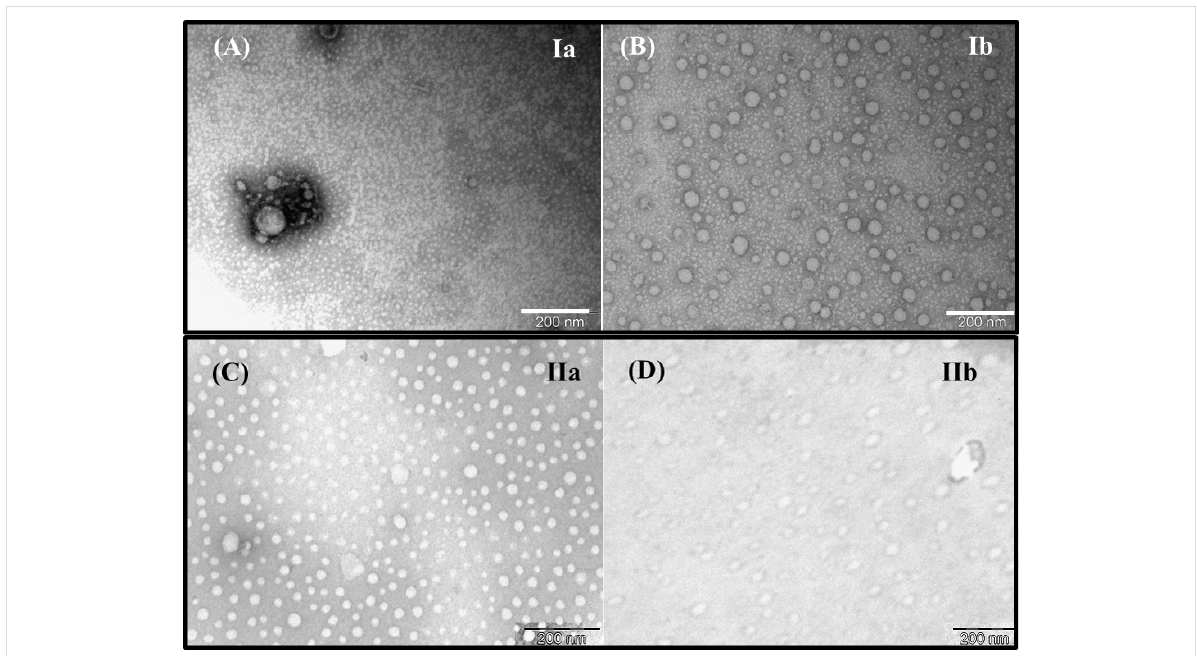
Figure 2: Representatives uranyl acetate negative stain transmission electron micrographs (TEM) of fullerene–androsterone conjugates.